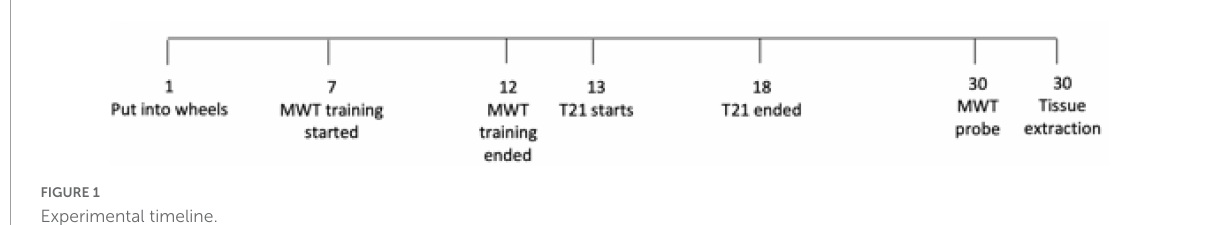
FIGURE1 Experimental